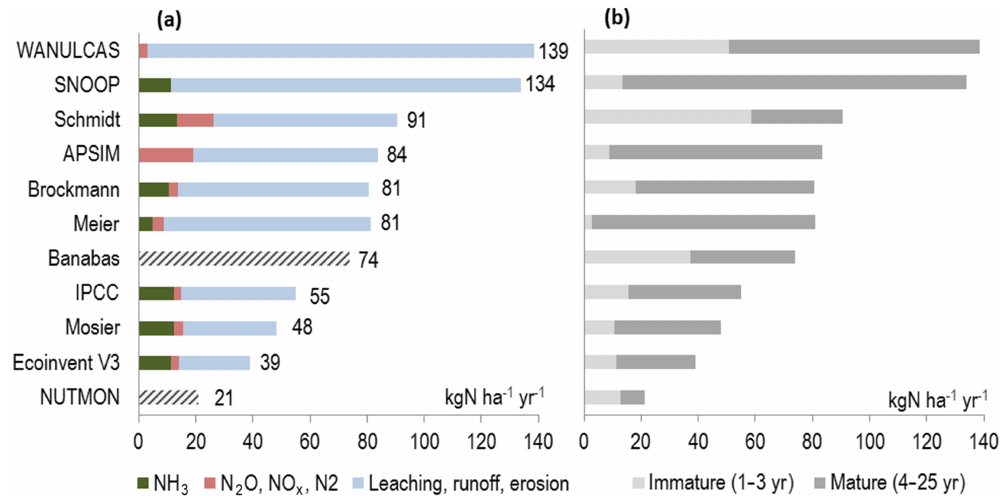
Figure 1. Estimates of N losses by 11 models. (a) Distribution of the annual average losses between the three pathways: leaching and runoff; NH 3 volatilisation; N 2 O, NO x , N 2 emissions. Overall losses of N were very variable, with an average of 77kg Nha − 1 yr − 1 , ranging from 21 to 139kg Nha − 1 yr − 1 . The leaching and runoff pathway was the most important of the three, corresponding to about 80% of the losses. The hatched bars represent calculations including several pathways at once: Banabas estimated the three pathways jointly, NUTMON estimated jointly all gaseous emissions and leaching losses were negative. SNOOP estimated N 2 , N 2 O, and NO x emissions as null, and APSIM and WANULCAS did not model the NH 3 volatilisation. (b) Distribution of the annual average losses between the immature and the mature phases, corresponding to 1–3 years, and 4–25 years after planting; respectively. On average, 31% of the losses occurred during the immature period, which represents 12% of the cycle duration.